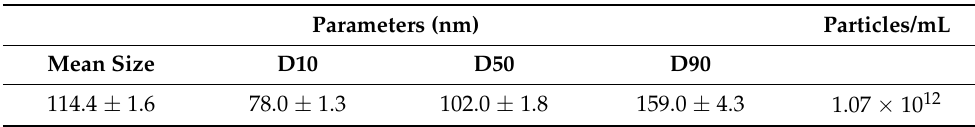
Table 2. NTA results: mean size, distribution (D10, D50, D90), and particle concentration of LPNP- TS-DOX.